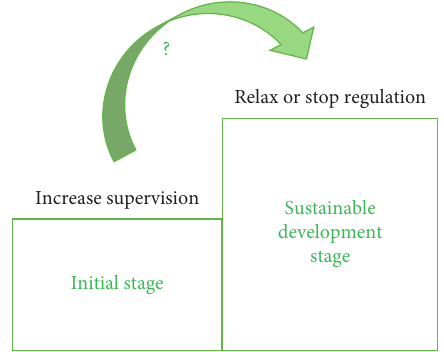
Figure 9: Initial promotion and sustainable